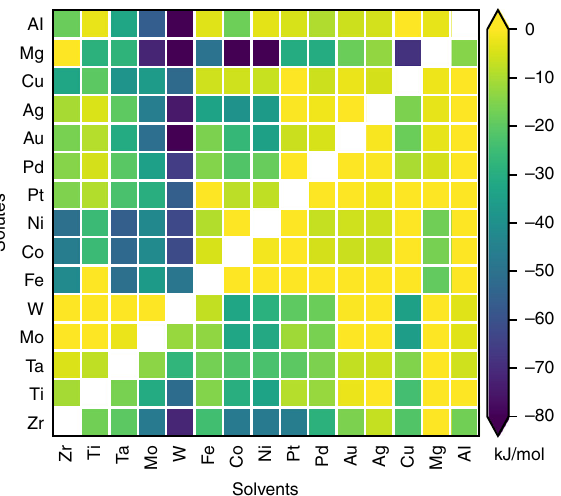
Fig. 6 Visual summary of the predicted segregation tendency across the alloy space. The value of the fi rst quartile of the segregation spectra (i.e. 25% of GB sites have lower segregation energies) as predicted using the accelerated model for 210 alloys (we removed columns with empty entries for compact viewing); the elements are arranged by their order on the Pettifor chemical scale 61 . For alloys with multiple interatomic potentials (see Supplementary Fig. 1), we report the least segregating spectra as a conservative choice (see Supplementary Fig. 25 for an alternative version of the fi gure with the most segregating